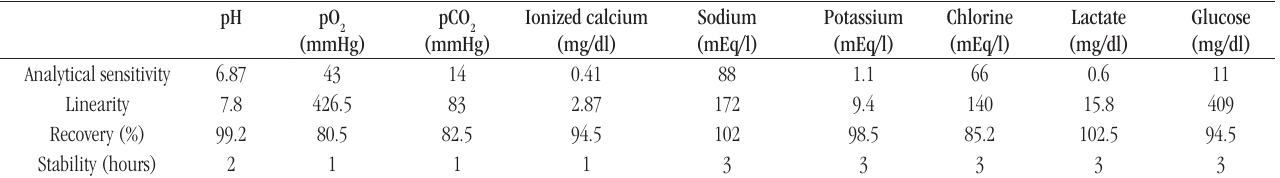
taBLE 2 − Results for evaluation of linearity, analytical sensitivity, recovery, and stability